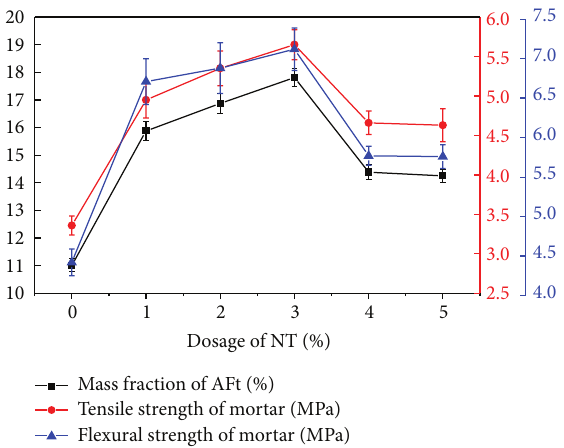
Figure 6: Relationships between flexural and tensile strengths and the AFt content at 28